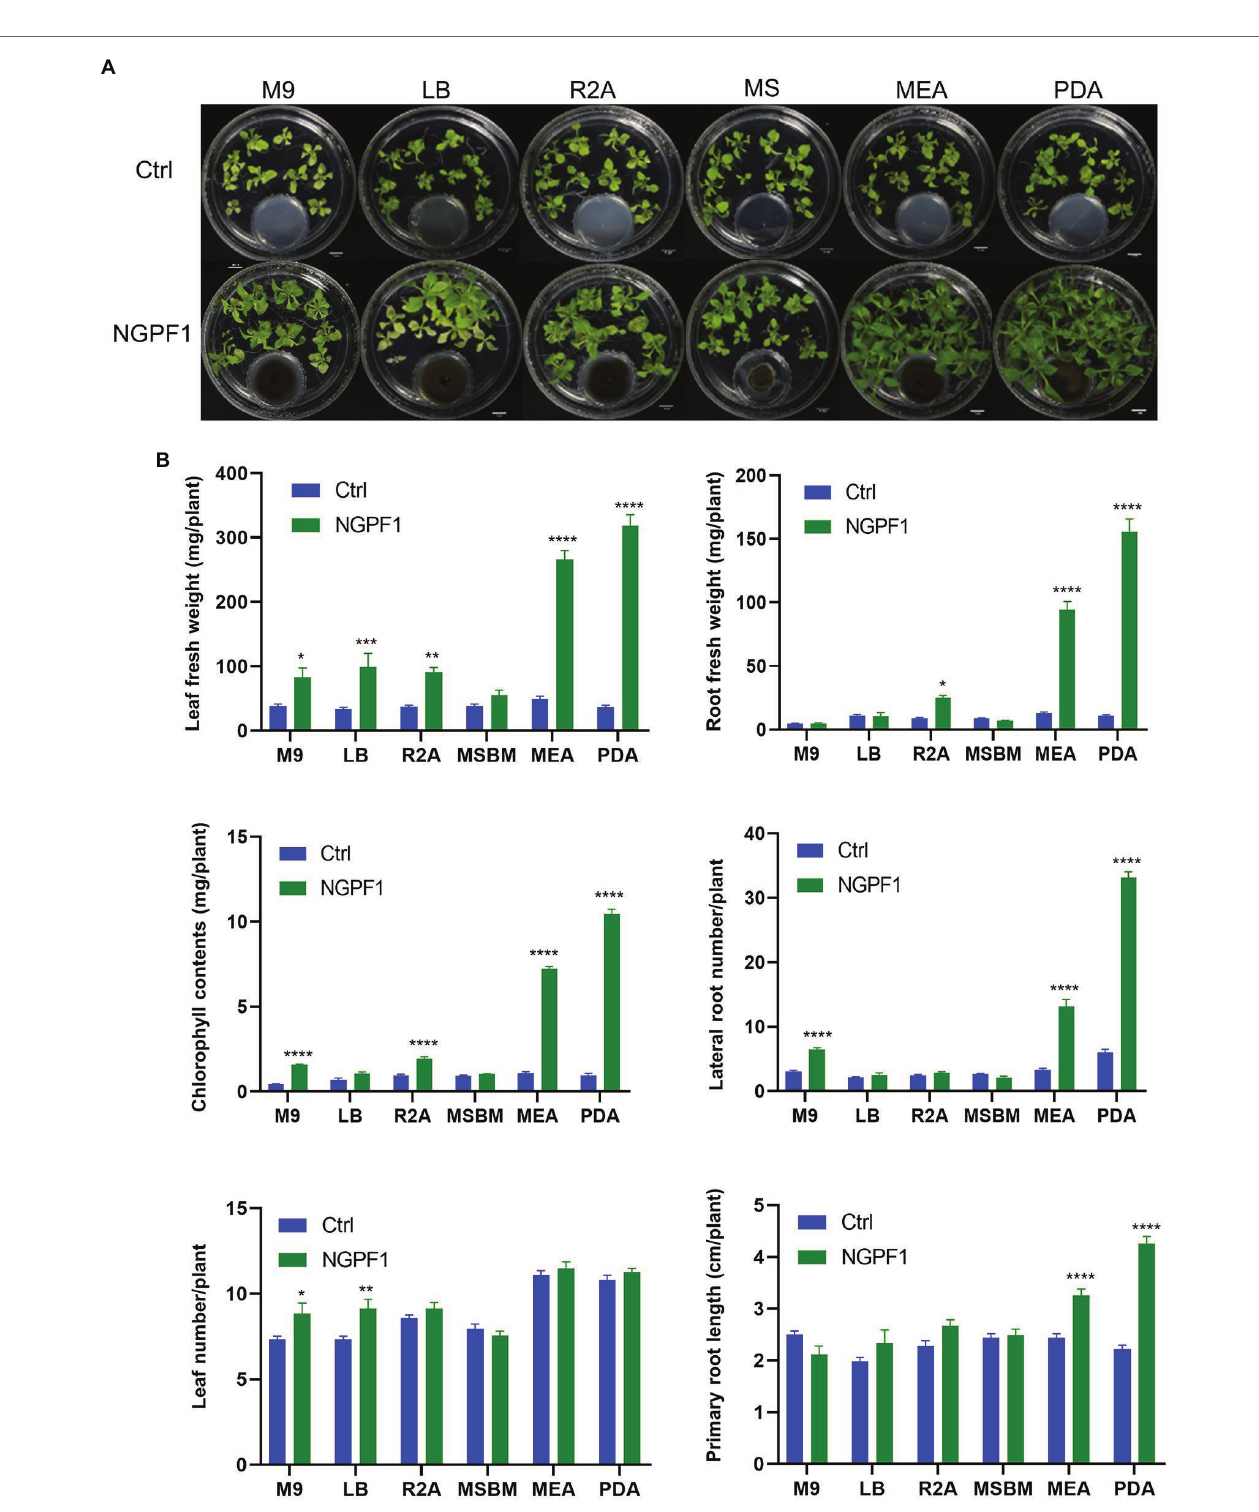
FIGURE 4 | Degree of plant growth promotion mediated by VOCs of C. halotolerans NGPF1 on culture medium-dependent. (A) Nicotiana benthamiana growth on MS medium after co-cultivation with VOCs emitted by C. halotolerans NGPF1 grown on different culture media. (B) Quantification of leaf fresh weight, leaf number, chlorophyll contents, root fresh weight, lateral root number, and root length after exposure to fungal VOCs. Error bars indicate the standard deviation of the mean ( n = 18). Asterisks indicate a statistically significant difference between control (ctrl, no treatment) and NGPF1 treatment (two-way ANOVA, * p < 0.05, ** p < 0.01, *** p < 0.001, and **** p < 0.0001). Experiments were repeated three times with similar